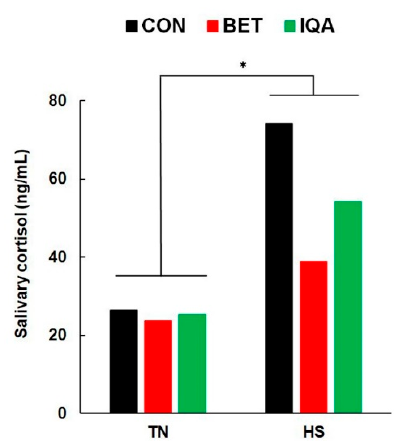
Figure 2. Effect of thermoneutral (TN) and heat stress (HS) conditions on salivary cortisol concentrations of growing pigs fed a control diet (CON), the control plus betaine (BET), or the control plus isoquinoline alkaloids (IQA). Each bar represents the pooled effect of saliva collected on days 1 and 2 of the heat challenge. Due to sample heterogeneity, the results were transformed (log 10 ) before analysis, then presented as mean of back-transformed means. HS significantly increased salivary cortisol (* p = 0.010). No effects of diet or interactions with temperature were observed. n = 8–9 pigs per group, with values representing adjusted means ± pooled SED for the interaction between T × D.